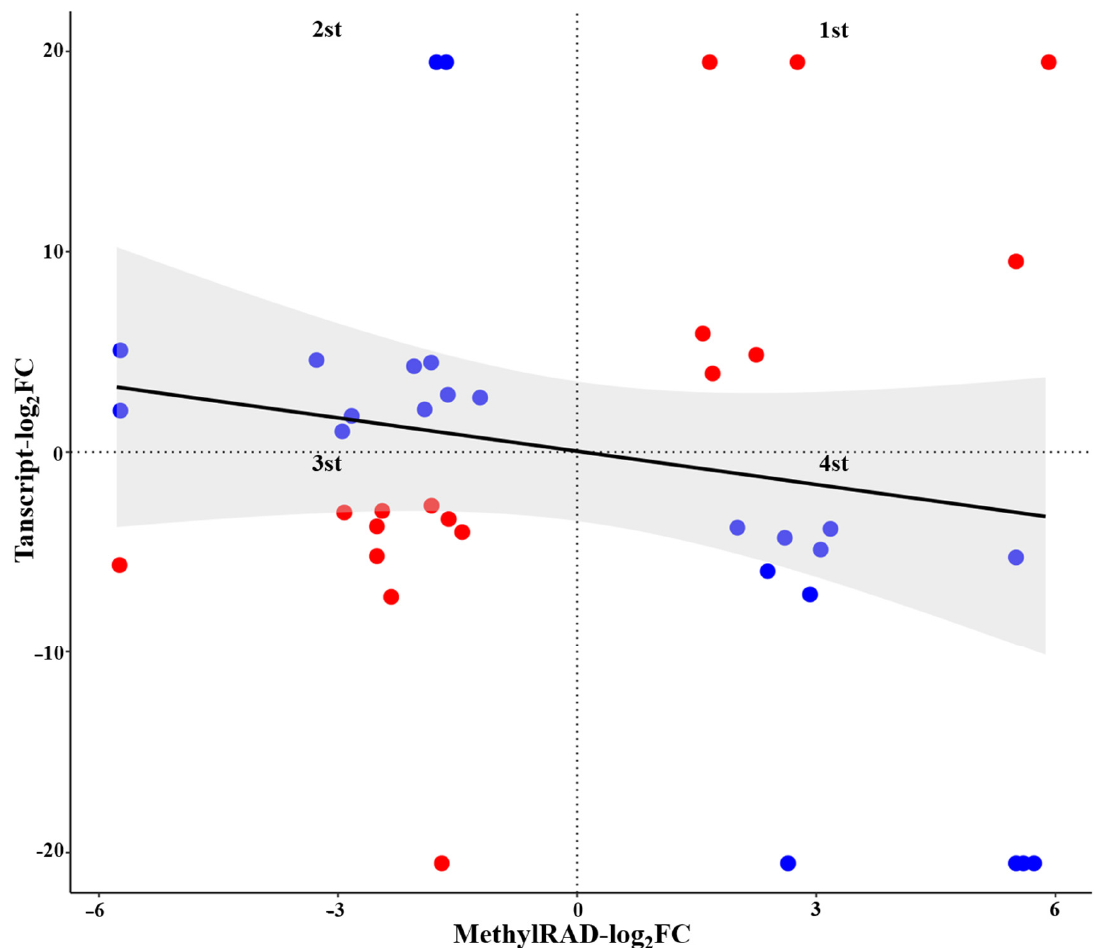
Figure 8. The correlation between differentially expressed genes (DEGs) and differentially methylated genes (DMGs). Note: Red dots indicate that the methylation level of the gene is negatively correlated with its expression level, and blue dots indicate that the methylation level of the gene is positively correlated with its expression level. The grey shadow indicates that the correlation between the methylation level and expression level is not significant ( p > 0.05).